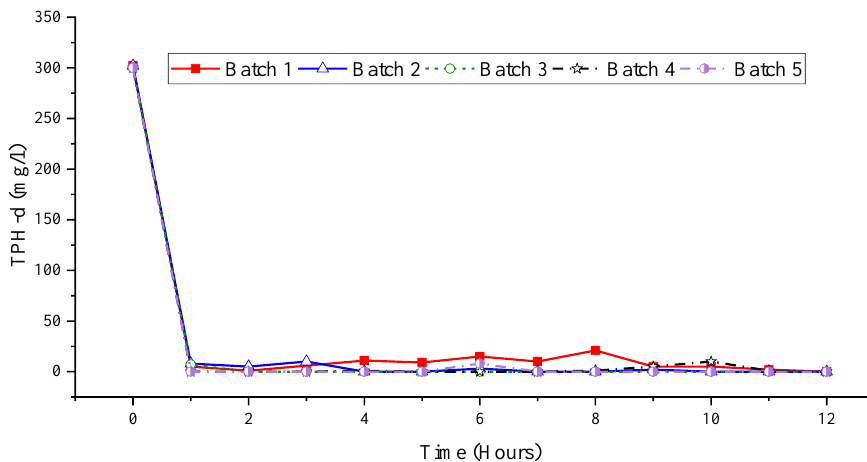
Figure 4. Degradation of diesel in groundwater over time by ozone and perozone sparging.